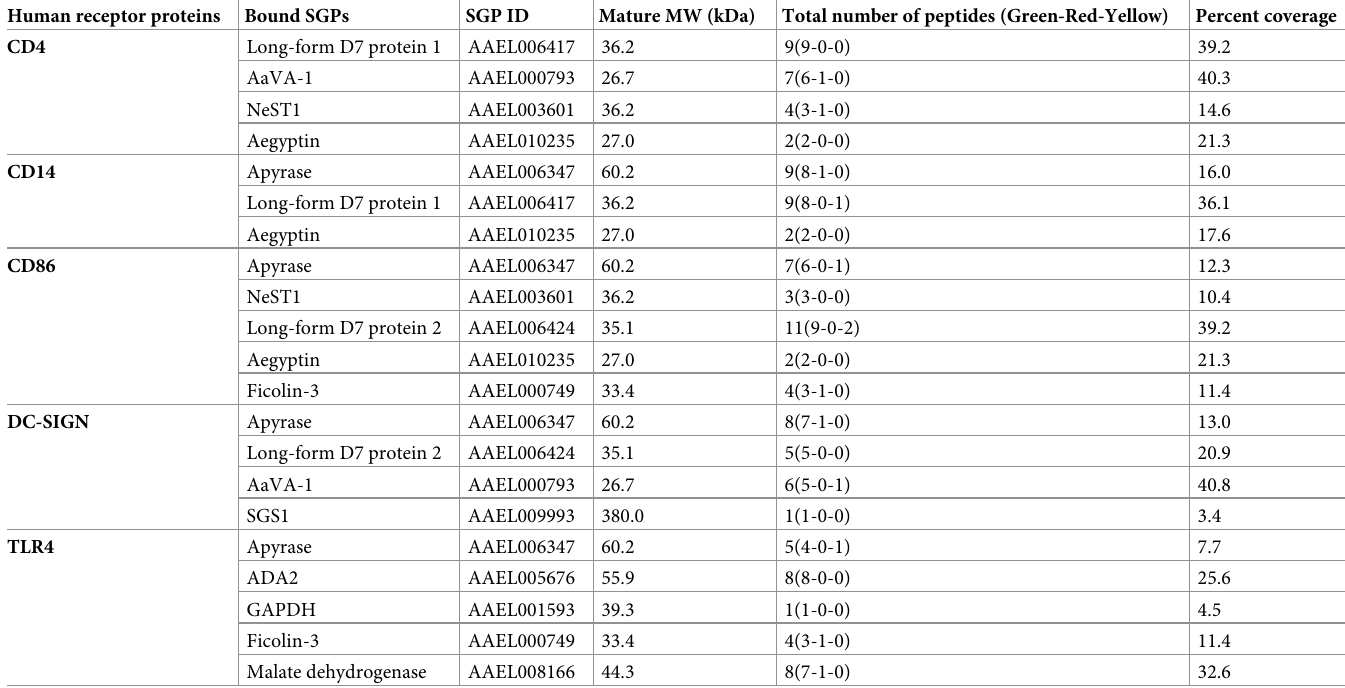
SGPs: Salivary gland proteins; AaAVA-1: Ae. aegypti allergen 1; NeST1: Neutrophil stimulating protein 1; SGS1: Aedes aegypti salivary gland surface protein 1. GAPDH: glycerol-3-phosphate dehydrogenase. The green-red-yellow peptides are found in S5–S10 Figs . Green represents positive reliable peptides, yellow represents low confidence peptides and red represents very poor intensity